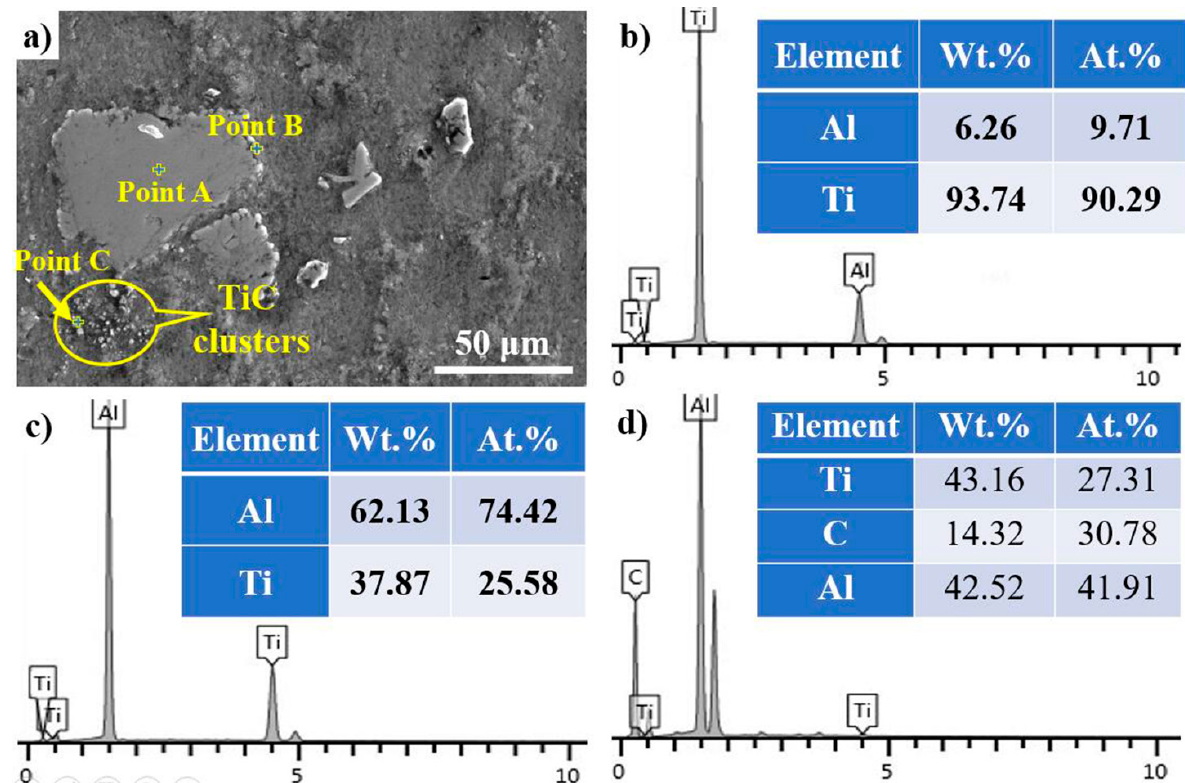
Figure 6. ( a ) The secondary electron image of undissolved Ti chips; and the EDS spectrums of ( b ) point A, ( c ) point B, and ( d ) point C.